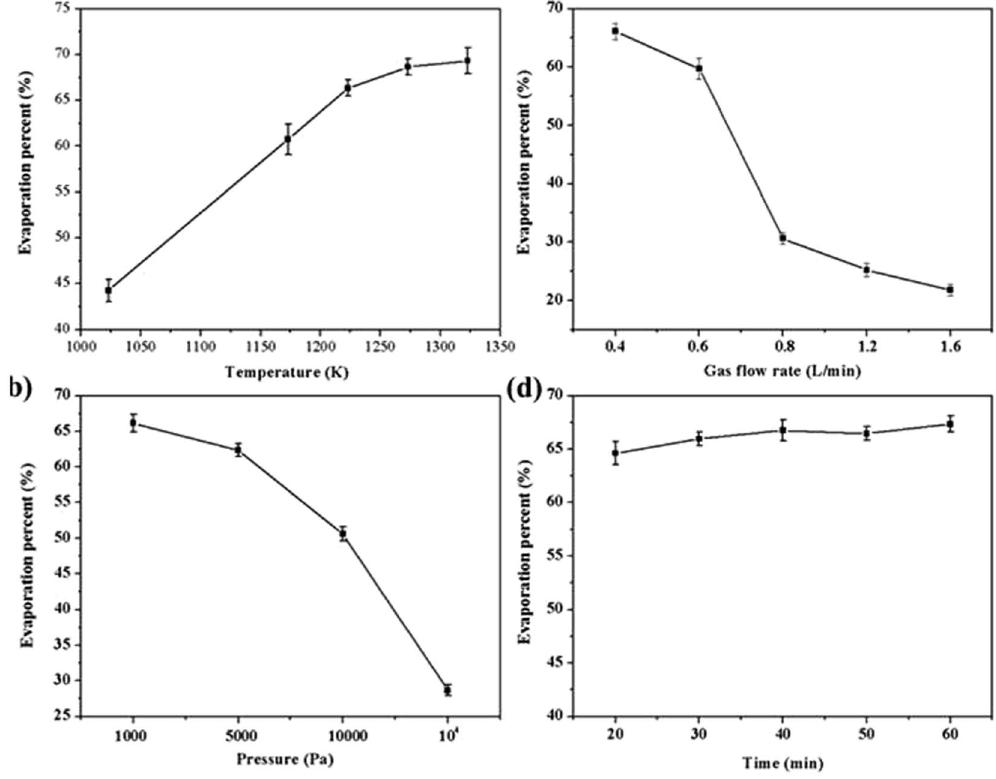
Figure 4. Effects of ( a ) temperature, ( b ) gas flow rate, ( c ) pressure and ( d ) holding time on evaporation percent of